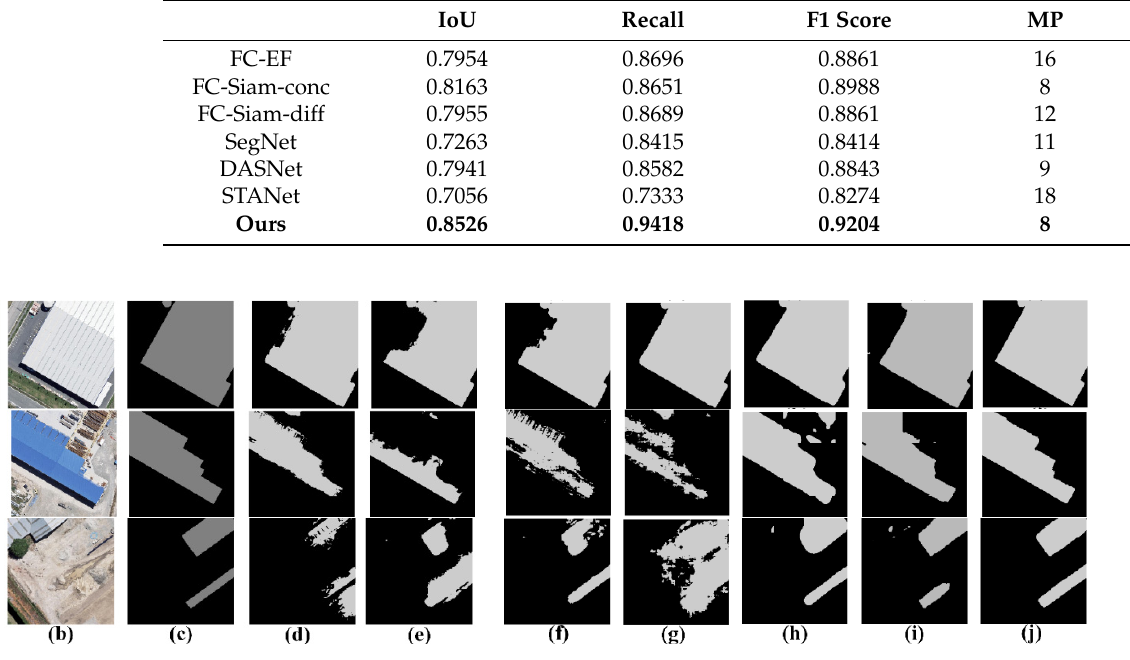
Figure 9. ( a ) Before image. ( b ) After image. ( c ) Label. ( d ) FC-EF. ( e ) FC-Siam-conc. ( f ) FC-Siam-diff. ( g ) SegNet. ( h ) DASNet. ( i ) STANet. ( j ) Ours.